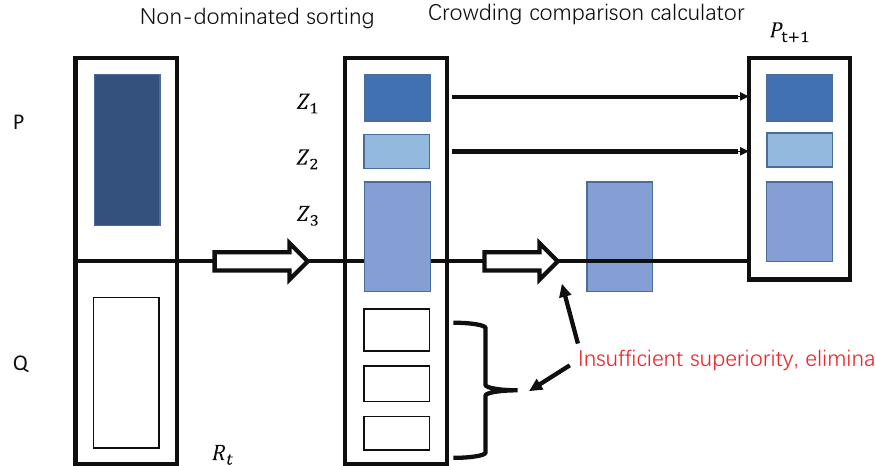
Figure 8. The implementation steps for NSGA-II’s elite strategy. The new population is ranked non-dominantly; in this example, the population is divided into six Pareto ranks, and non-dominant individuals with Pareto rank 1 and 2 are placed in a new set of parents, after which their crowding is determined before ranking those with Pareto rank 3 and excluding all those with ranks 4 to 6. This figure is adopted from